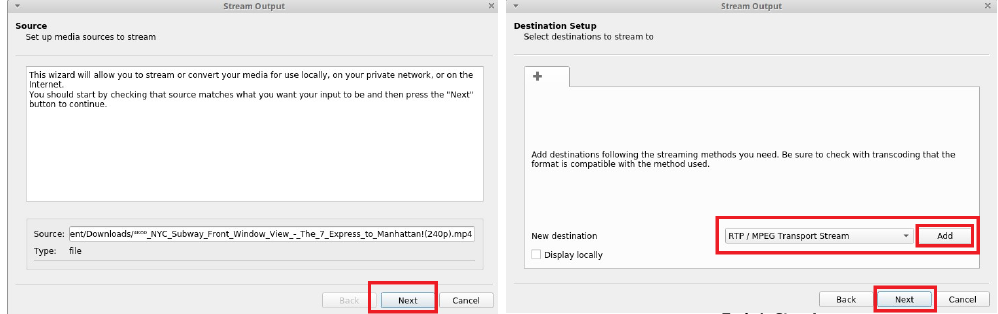
Figure 34. Train1: selecting the streaming method.